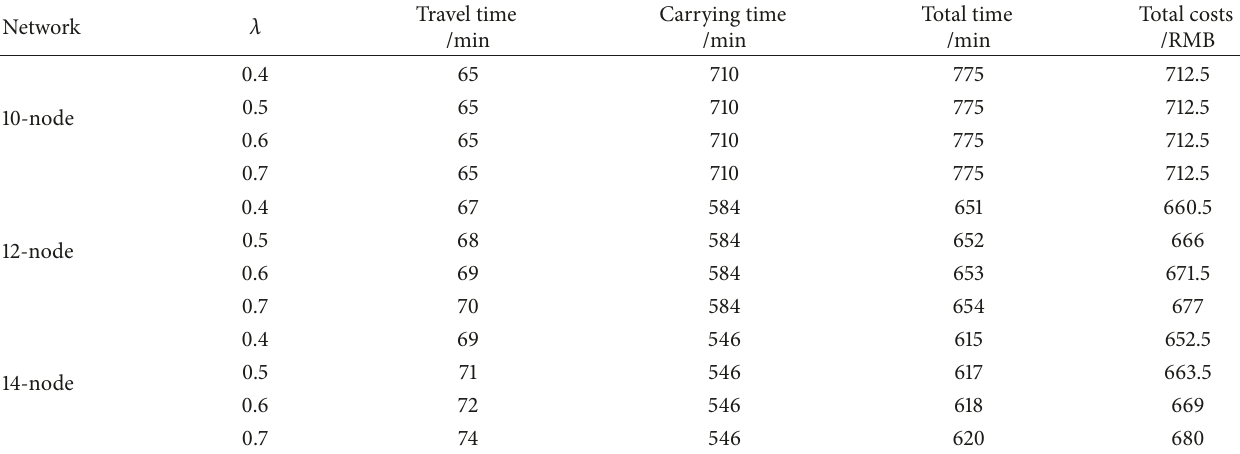
Table 3: The effects of the number of clustering